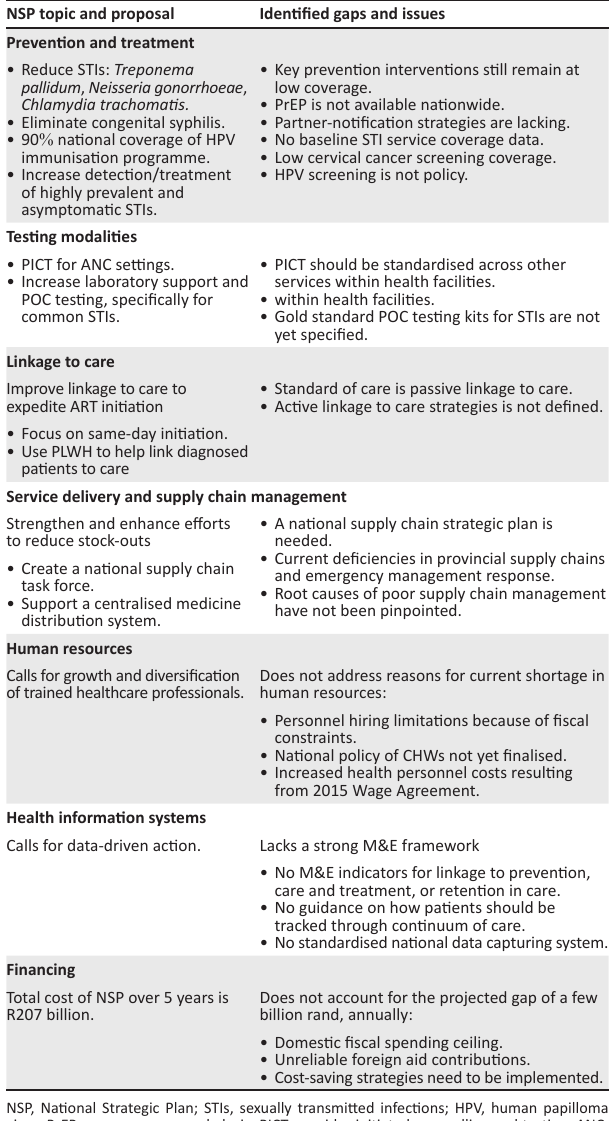
TABLE 1: Summary of gaps within the National Strategic